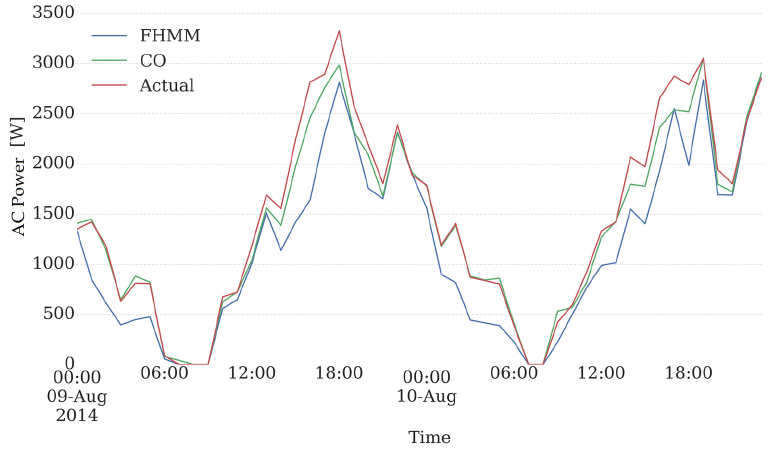
Figure 3. Comparison of CO and FHMM with actual consumption.